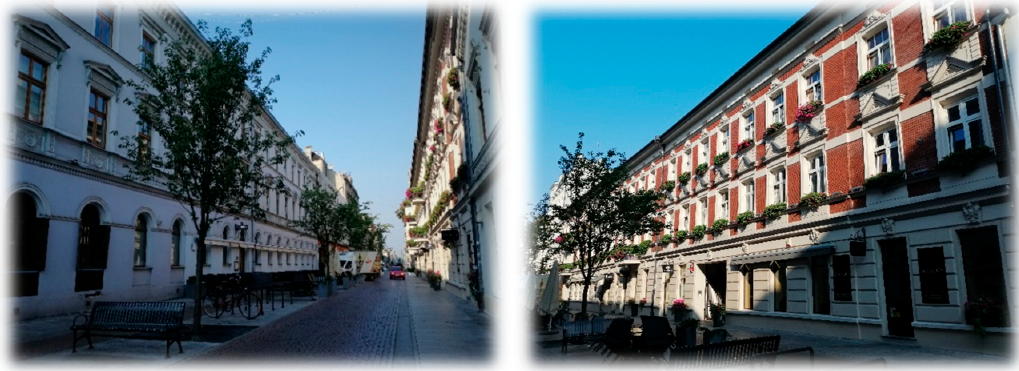
Figure 1. The structure of the historic urban core (the left photography—the south view of 6-Sierpnia Street; the right photography—the north view of 6-Sierpnia Street).